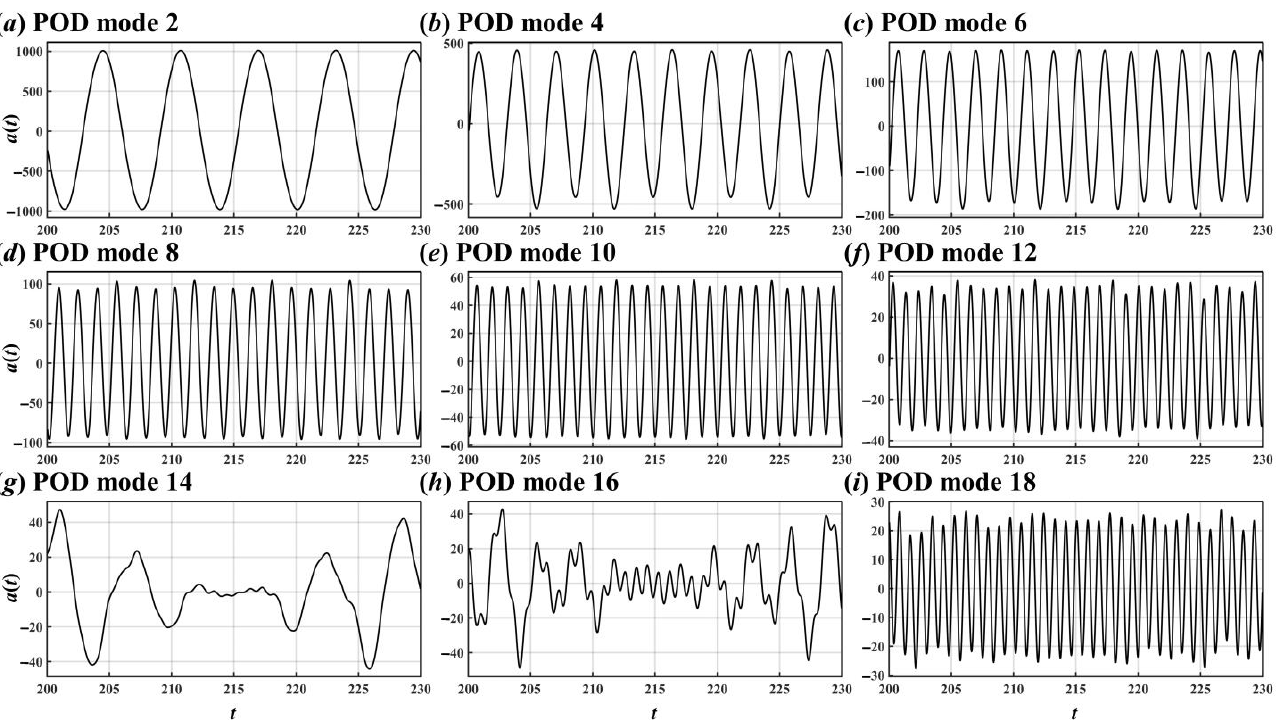
Figure 22. Time coefficients of the 2nd ( a ), 4th ( b ), 6th ( c ), 8th ( d ), 10th ( e ), 12th ( f ), 14th ( g ), 16th ( h ), and 18th ( i ) POD modes for the flow around the two crossing cylinders in 60° arrangement.